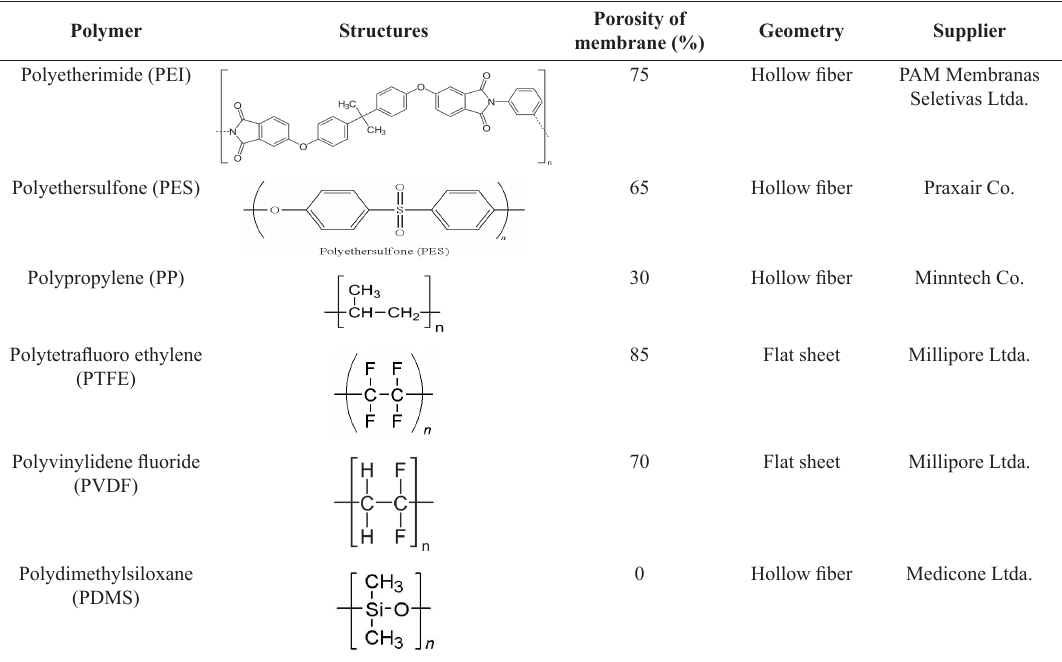
Table 1. Commercial membranes selected for ozone oxidation experiments. Polymer